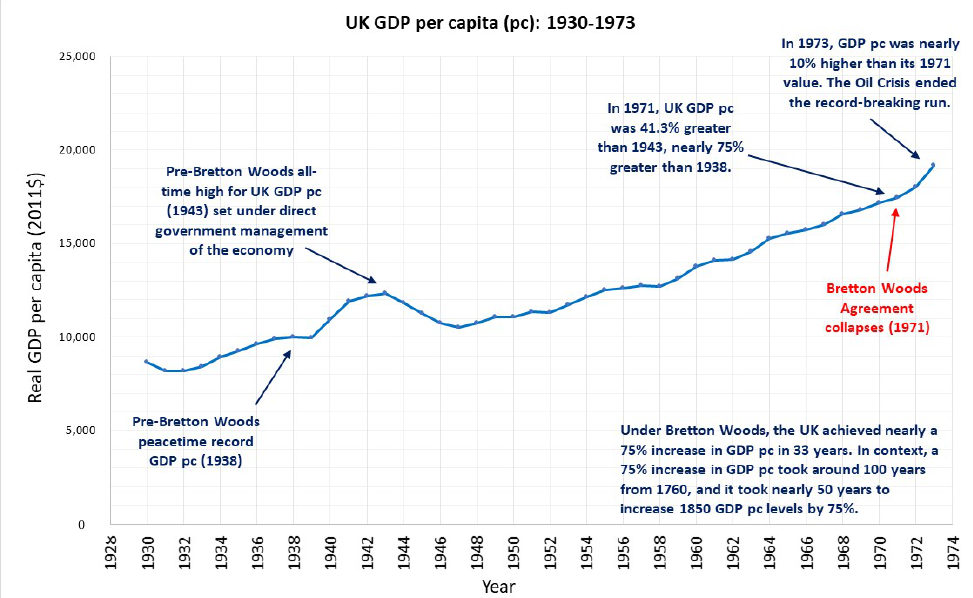
Figure 4. Despite poor productivity performance relative to international counterparts, the UK experienced its most successful period of growth to date under the Bretton Woods Agreement (see Note